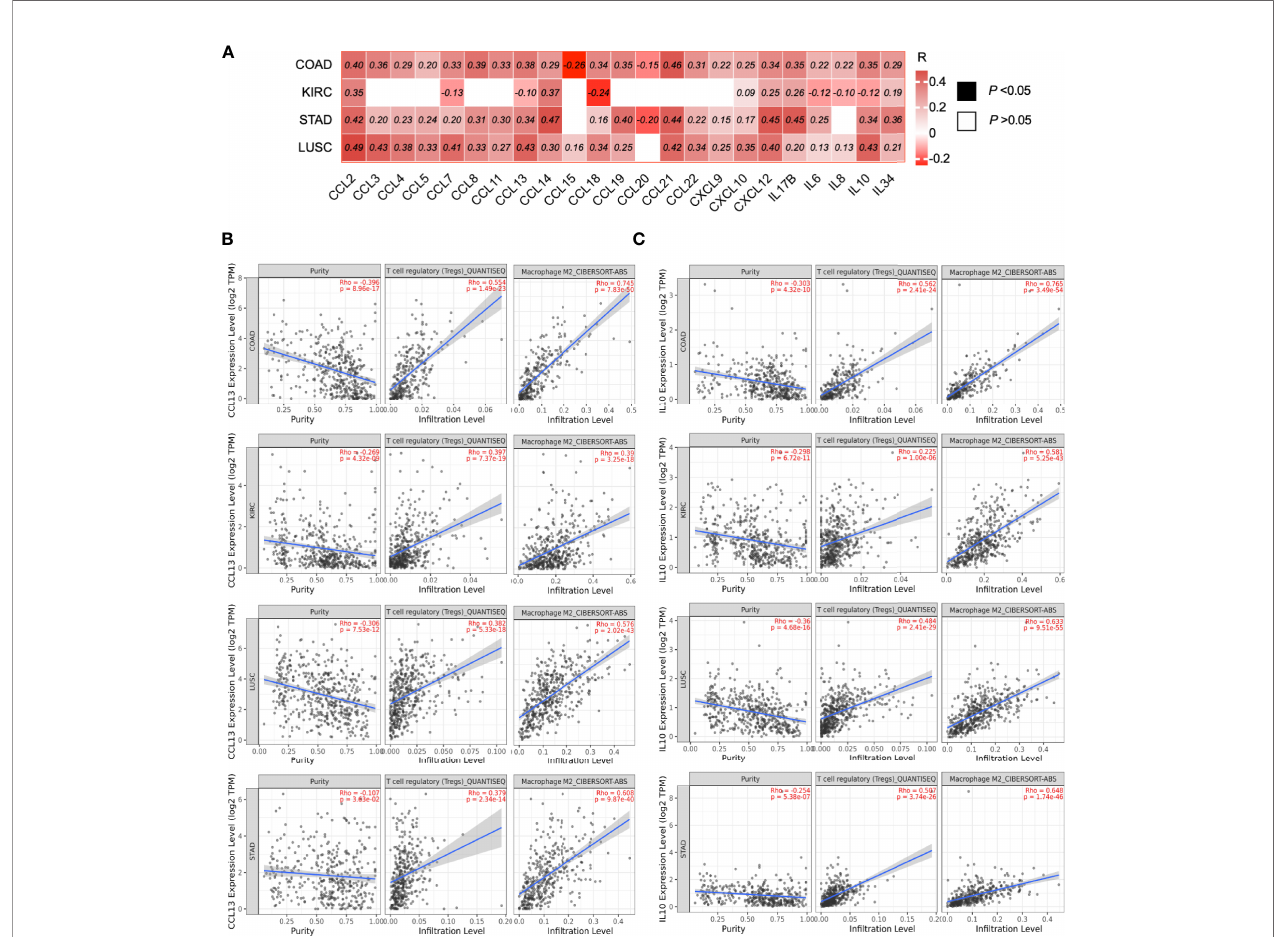
FIGURE 7 | ILK expression is correlated with the expression of chemokines and cytokines implicated in immunosuppressive cell in fi ltration. (A) Heat map of different chemokine and cytokine gene expression and their correlations with ILK in COAD, KIRC, STAD and LUSC were examined via TIMER. The values in the heat map are for the spearman ’ s correlation Rho, R. The scale on the right of the heat map is for R values. All colored squares are statistically signi fi cant whereas white squares are not statistically signi fi cant. The R values above 0.08 are statistically signi fi cant. (B) CCL13 correlation with tumor purity, Treg and M2 in fi ltration. (C) IL10 correlation with tumor purity, Treg and M2 in fi ltration. Signi fi cant P -value is